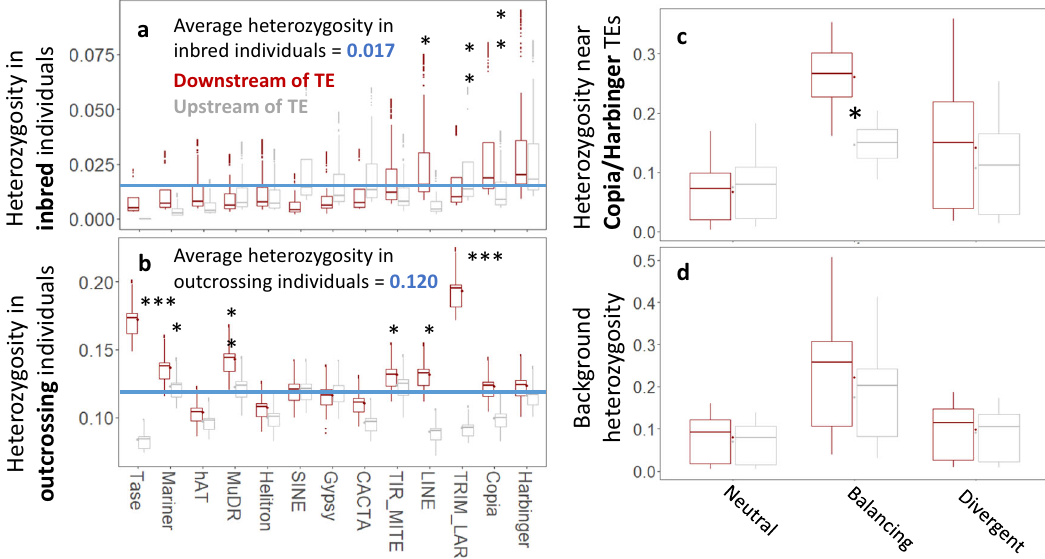
Fig. 3 | Heterozygosity across TE superfamilies in inbred and outcrossed indi- viduals. Heterozygosityininbredindividuals(genome-wide F IS >0.6)wasgenerally lowbutwaselevatednearCopia,HarbingerandLINEelements( a ).WhileCopiaand Harbinger elements can maintain heterozygosity particularly under inbreeding, only LINE elements are also associated with increased heterozygosity in out- crossing populations (genome-wide F IS <0.6) ( b ). We therefore considered the Copia and Harbinger elements to contribute to the “ TE Effect ” (Table 1). As the CACTA superfamily was associated with intermediate levels of heterozygosity in the American A. lyrata lineage, we used CACTA as the reference group (intercept) for statistical comparisons with other TE superfamilies in the mixed model output